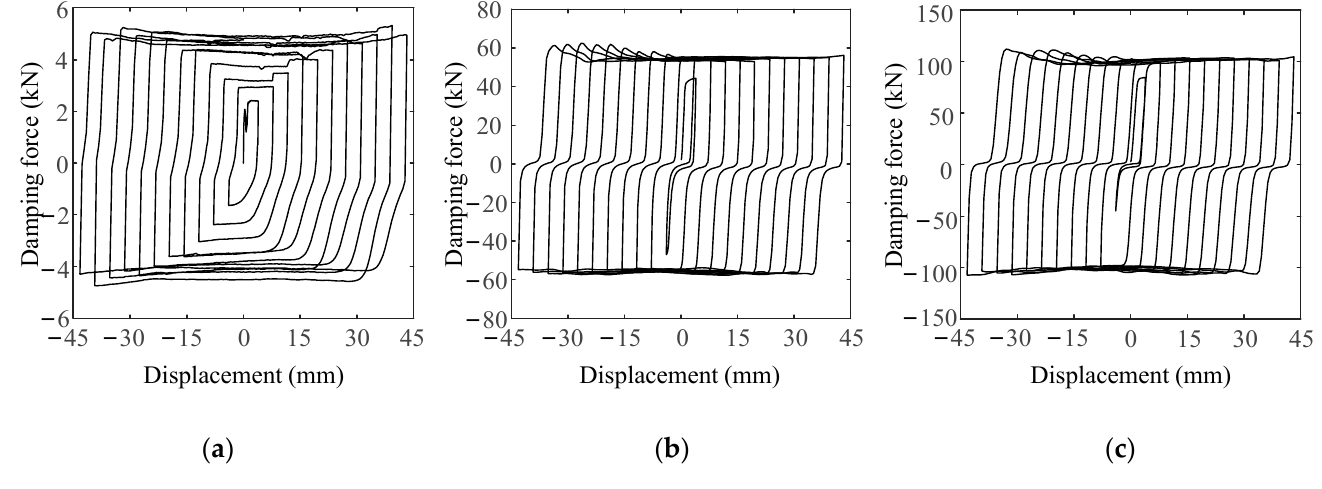
Figure 4. Damping force-displacement hysteresis loops of MRD at different current. ( a ) Current 0A; ( b ) current 0.14A; ( c ) current 0.28A.